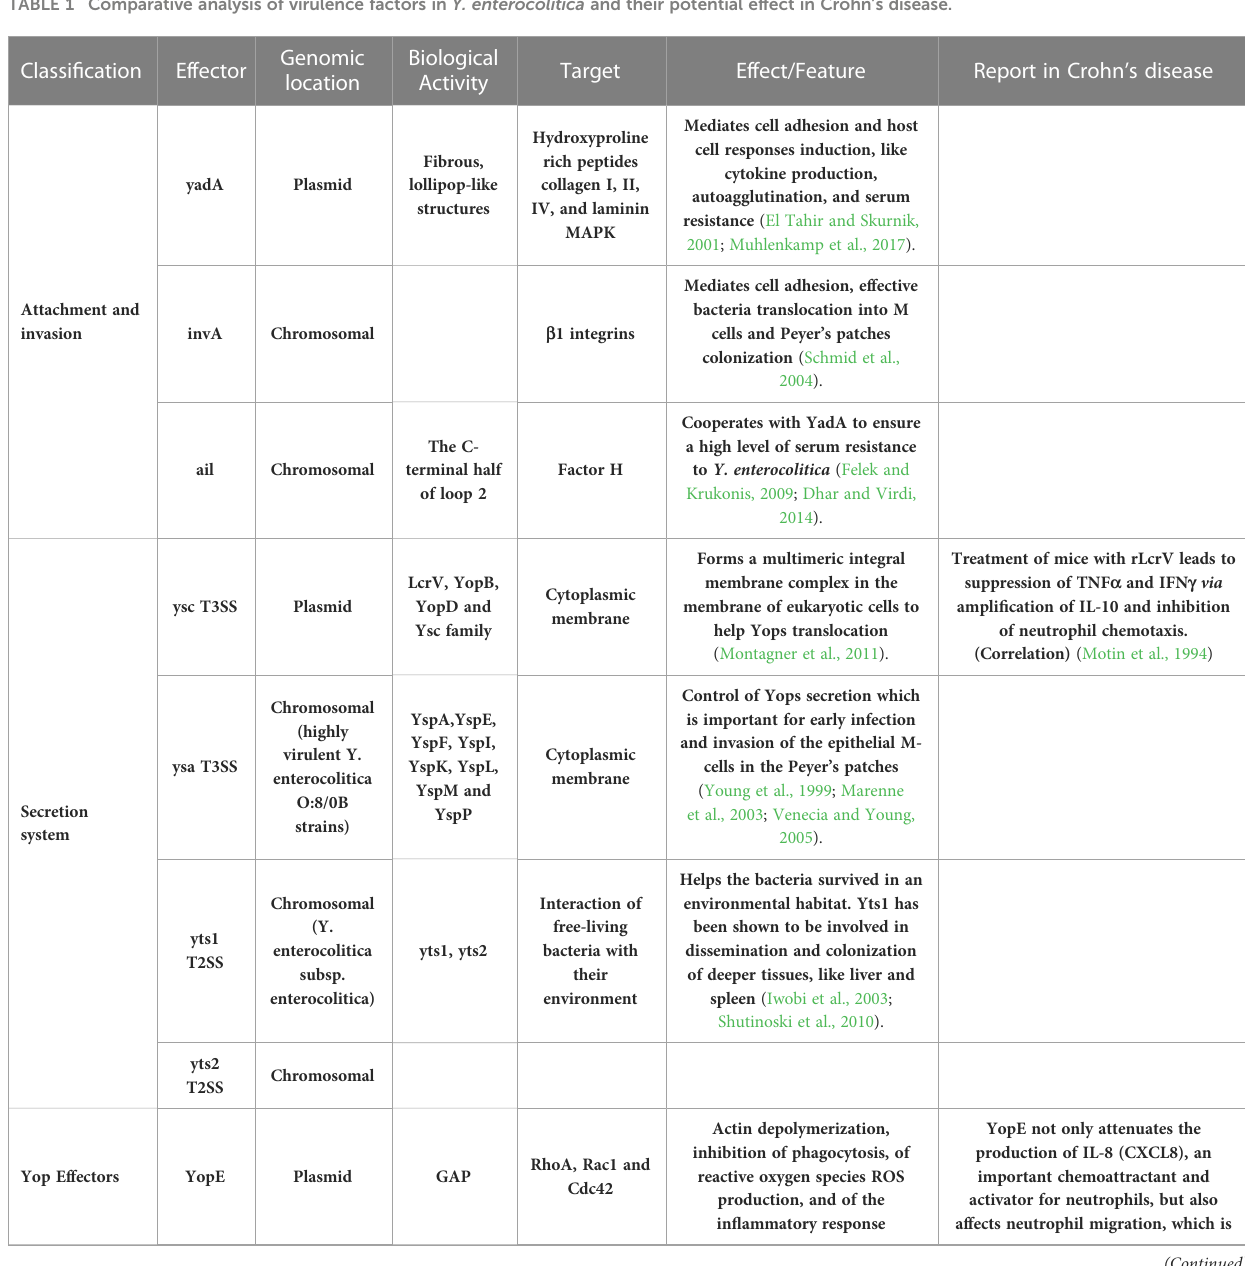
TABLE 1 Comparative analysis of virulence factors in Y. enterocolitica and their potential effect in Crohn ’ s